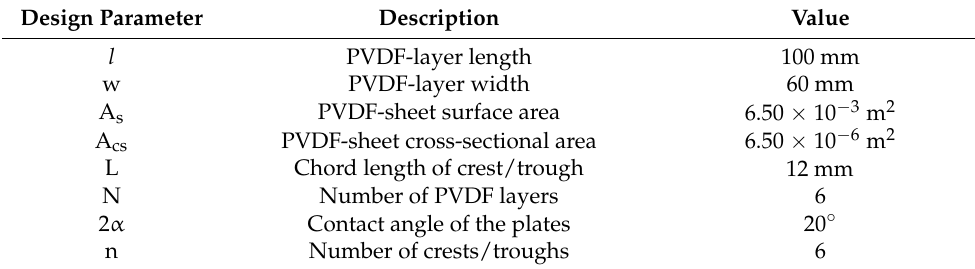
Table 2. Energy-Harvester-Design Parameters [21].